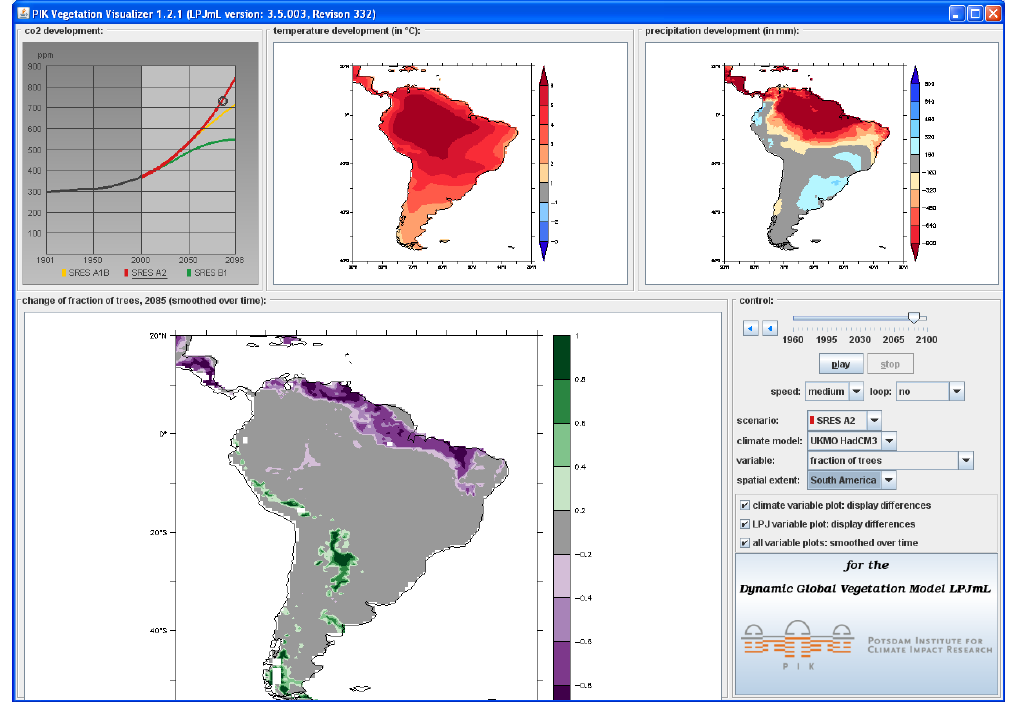
Figure 13. Screenshot of the Vegetation Visualizer tool [42] used to generate views of South America showing temperature development, precipitation development and changes in the fraction of